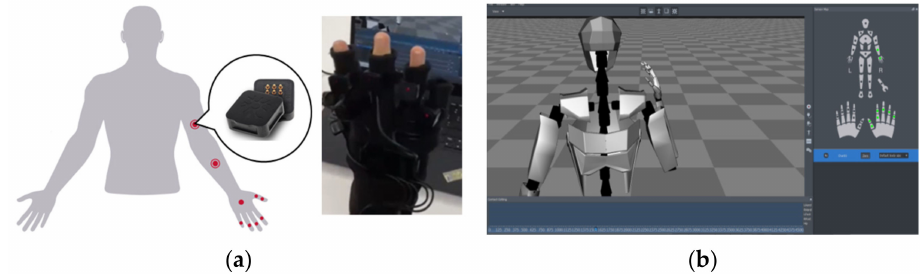
Figure 3. Perception Neuron motion capture system for right hand [27]: ( a ) distribution of sensors; ( b ) main interface of Axis Neuron